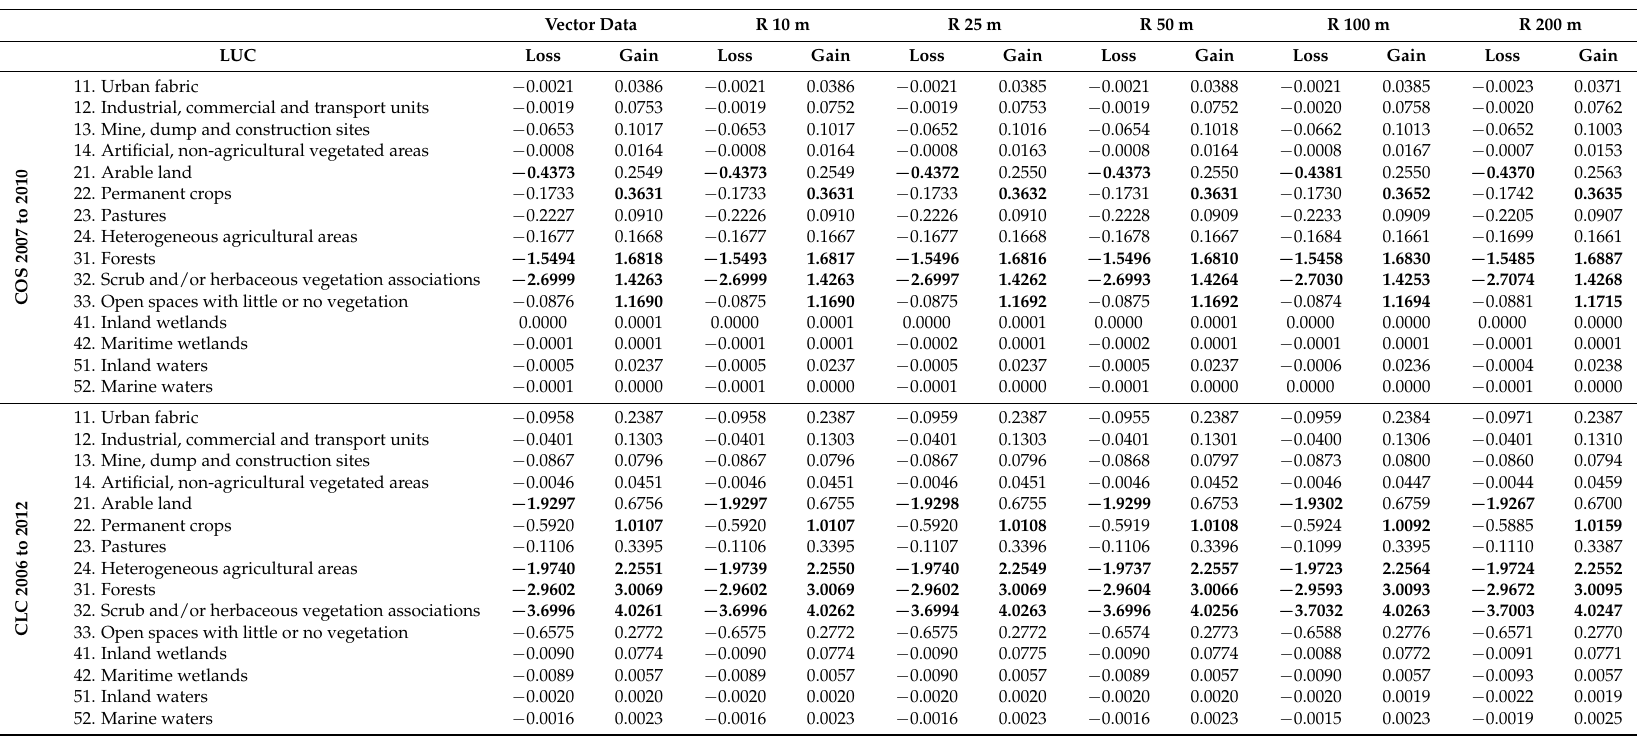
Table 6. Gain and loss area (% of mainland Portugal) by LUC type (absolute changes), obtained for different raster resolutions outputs. Values in bold represent above average gain and loss areas for each dataset (COS and